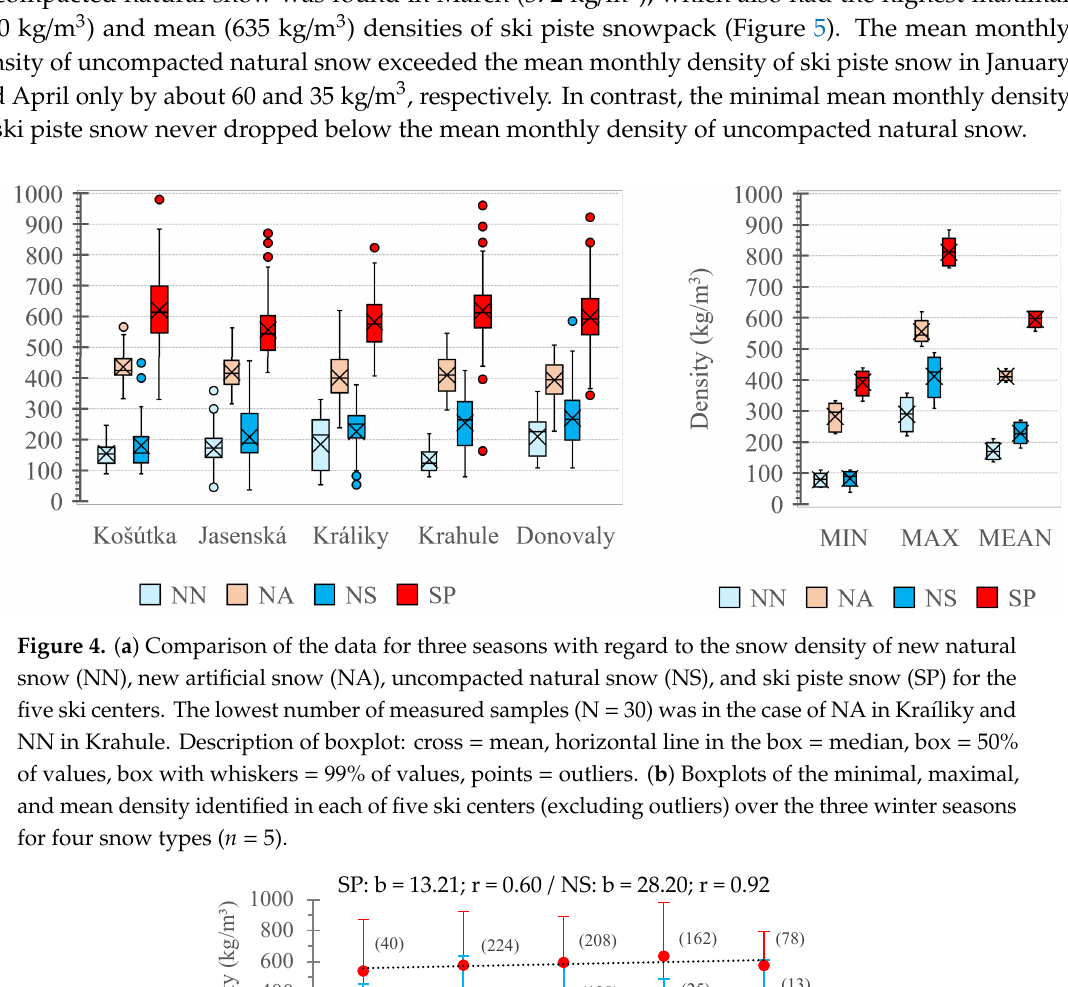
Figure 5. Increases in the mean monthly density of ski piste snow (SP) and uncompacted natural snow (NS) over the winter season (mean ± min/max). The means from three seasons calculated from all data measured at the five ski centers are displayed. b = slope of regression line, r = correlation coefficient, (x) = the total number of samples.